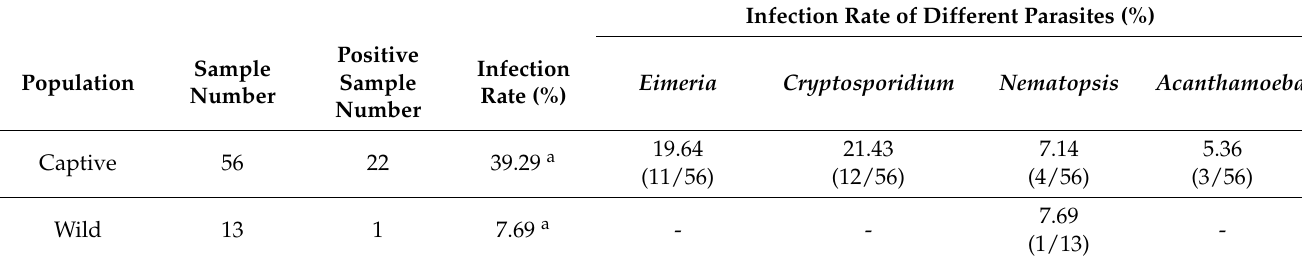
Table 2. Parasitic infection of crocodile lizards in different populations. Infection Rate of Different Parasites (%)